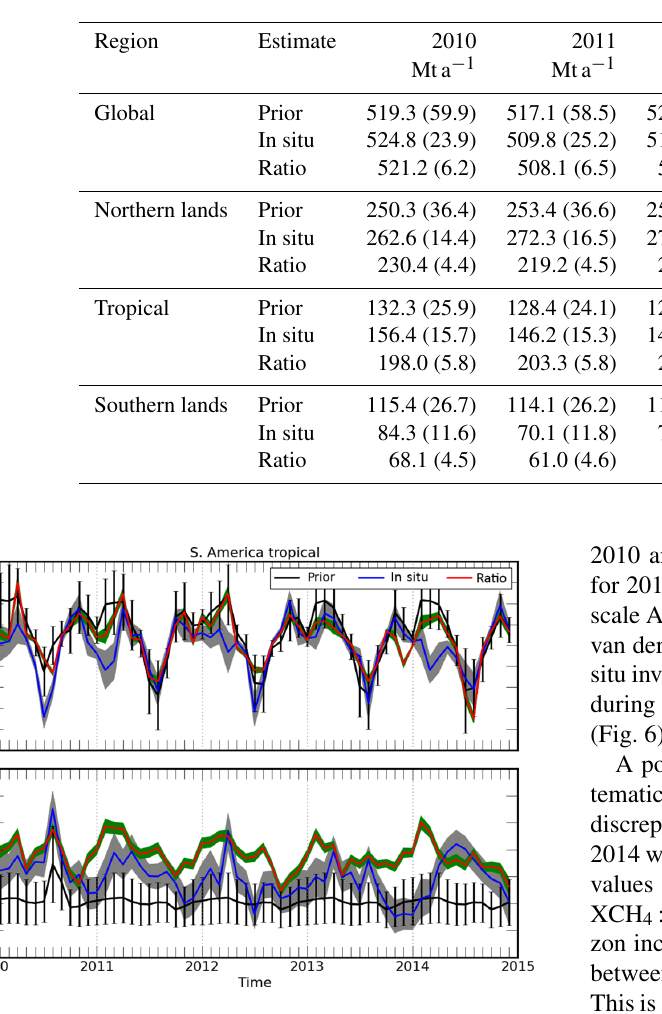
Figure 6. The same as Fig. 3 but for CO 2 and CH 4 fluxes over tropical South America (Fig.